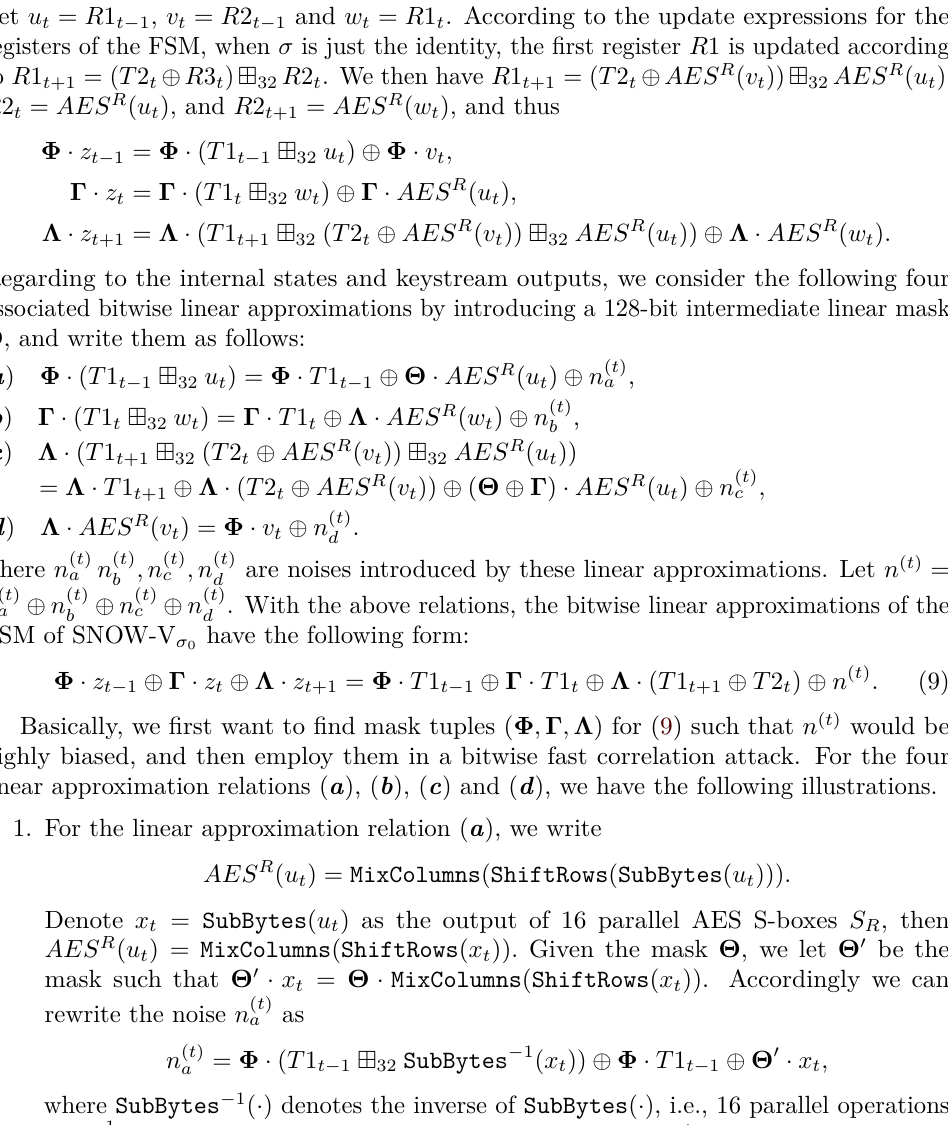
Figure 3: The FSM part of SNOW-V σ